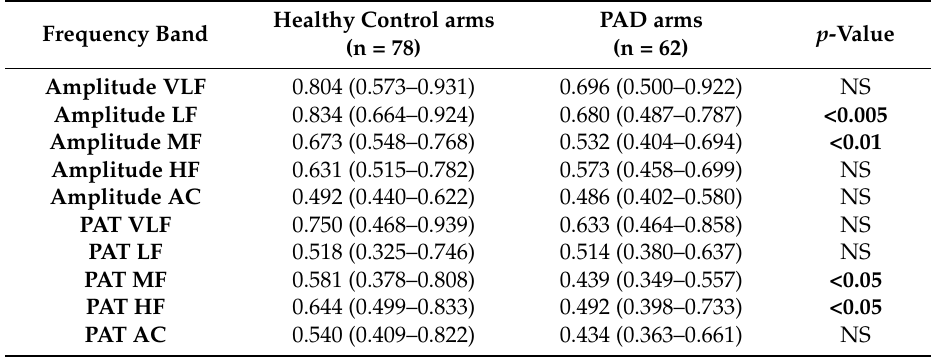
Table 6. Resampled normalized amplitude and PAT frequency analysis for the finger site. Median (IQR) values are shown. NS: